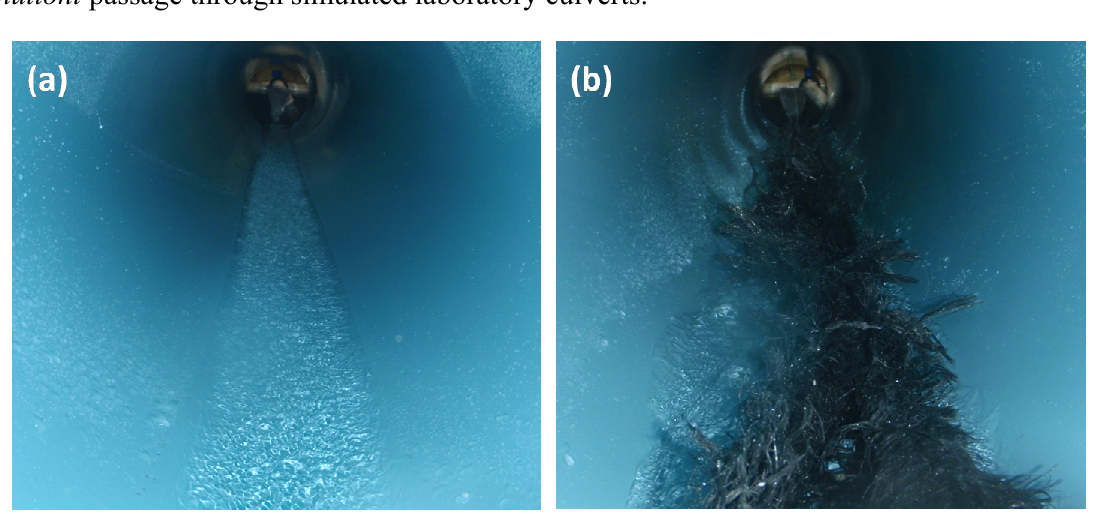
Figure 2. Different flow hydrodynamics between ( a ) control (no rope); and ( b ) treatment (rope) pipes, used to test the effect of mussel spat rope on redfin bully Gobiomorphus huttoni passage through simulated laboratory